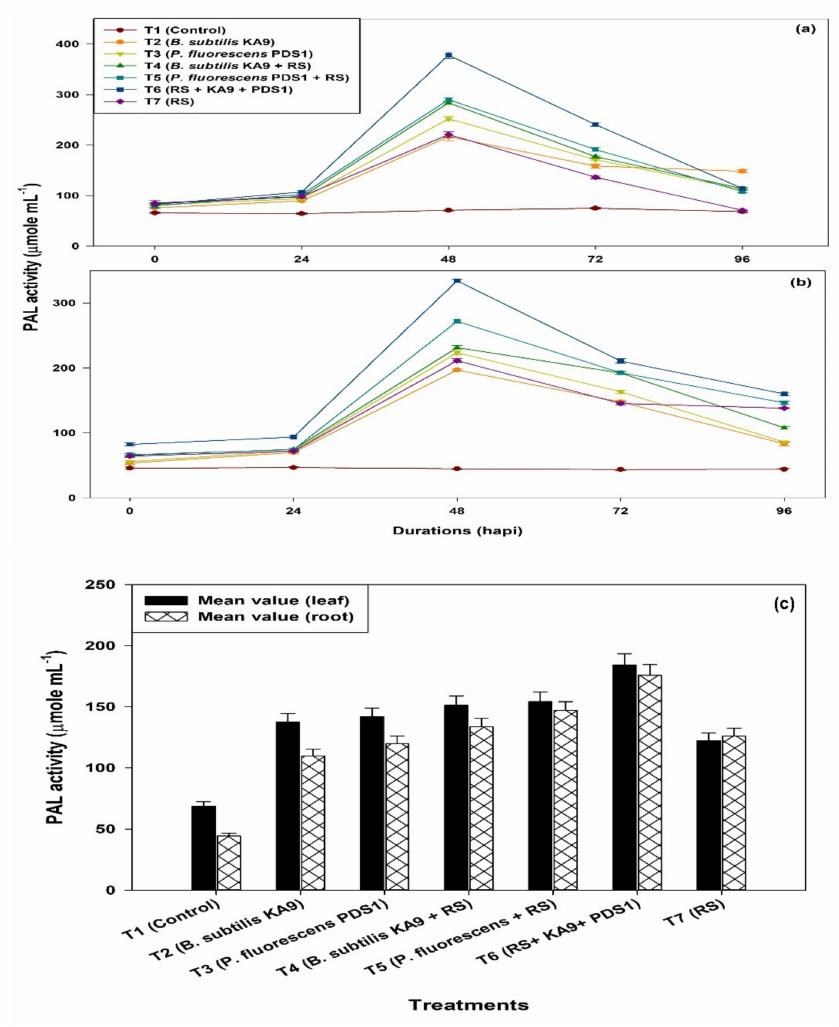
Figure 13. ( a ) The effect of biocontrol agents on the induction of phenyl ammonium lyase (PAL) ac- tivities in leaves of chilli crop against R. solanacearum in glasshouse conditions and observations were recorded after 30 days of sowing ( b ) Effect of biocontrol agents on induction of phenyl ammonium lyase activities in roots of chilli crop against R. solanacearum in glasshouse conditions; observations were recorded after 30 days of sowing. The results are expressed as average of three replications and error bars indicate standard deviation of the means. ( c ) Mean value comparison of the induc- tion of phenyl ammonium lyase (PAL) activities in between chilli leaves and root tissue against R. solanacearum in glasshouse conditions after 30 days of sowing. The results are expressed as average of three replications and error bars indicate standard deviation of the